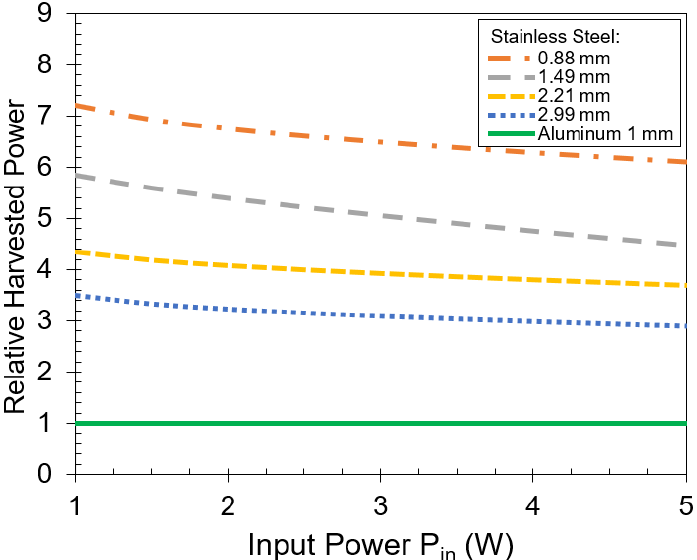
Figure 12. Relative harvested power through stainless steel plates to through a 1 mm-thick aluminum plate versus input power. The frequency is 2 kHz.